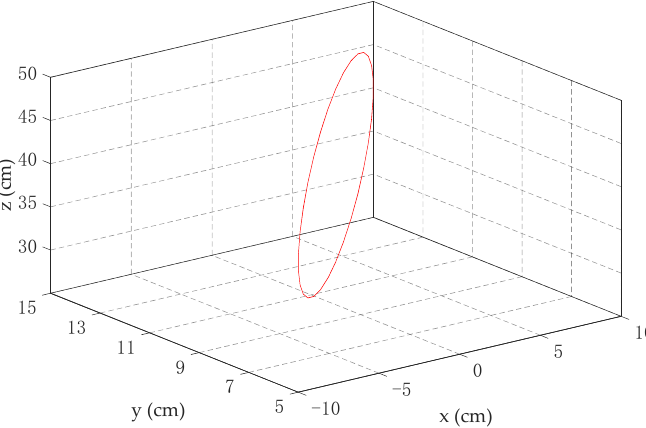
change curves of four joint angles are shown in Figures 7 and 8, respectively.